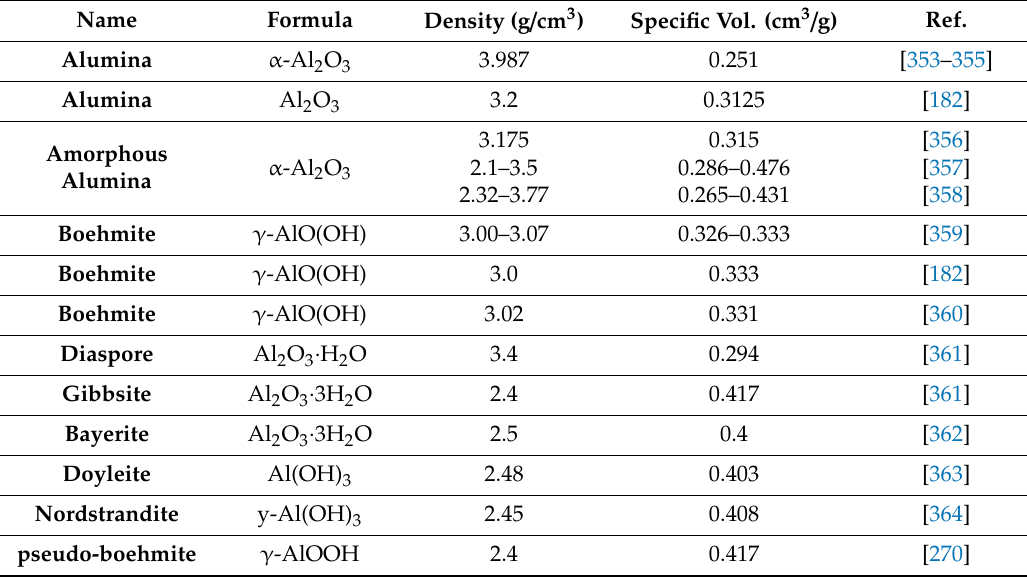
Table 6. Some relevant physical properties of aluminum oxides and (oxy)hydroxides.